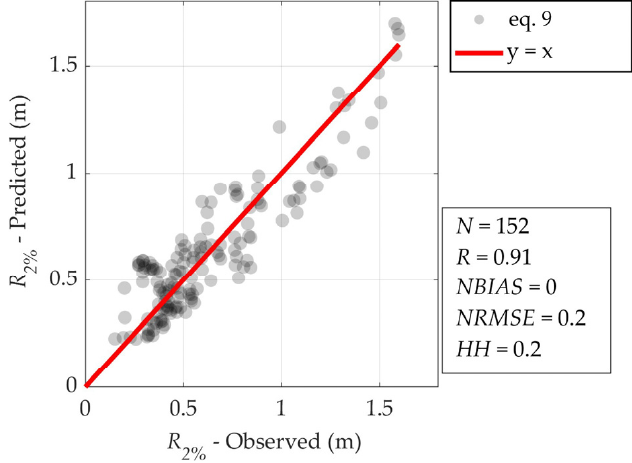
Figure 10. Comparison between the observed runup values on fetch-limited pocket beach Plo č e and those predicted using the modified P16a equation by including the Goda peakedness parameter, Qp (Equation (9)).